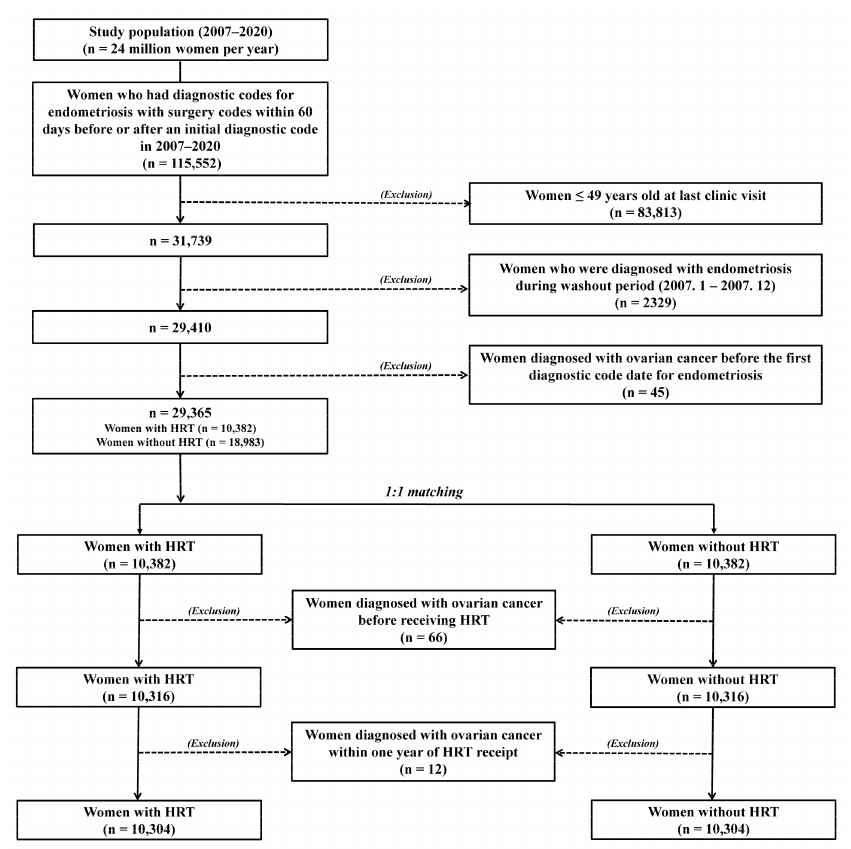
Figure 1. Flow chart showing selection of eligible